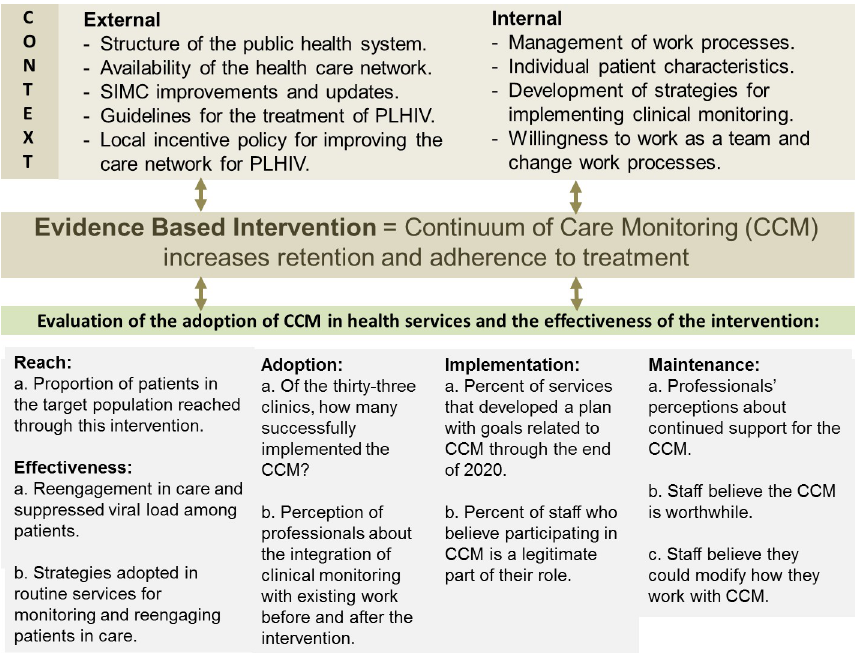
Fig 1. Pragmatic model with contextual factors considered in the conducting continuum of care interventions and measurements. Virologic failure: Patients who received the intervention